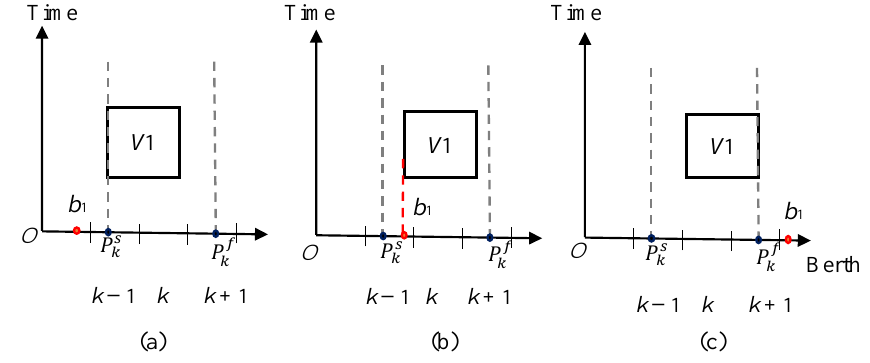
Figure 3. The setting method of berthing